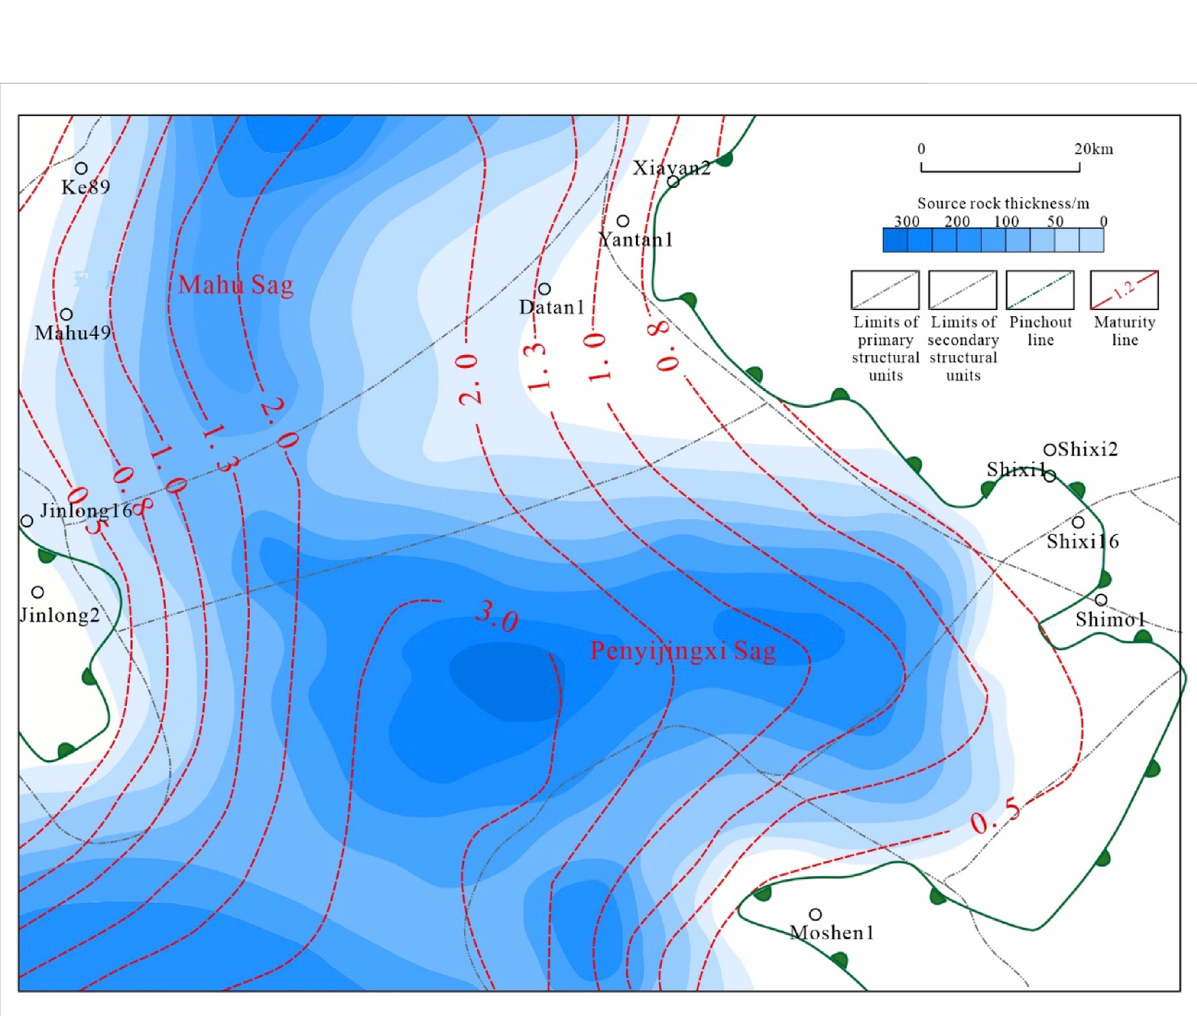
FIGURE 7 Map showing the source rock thickness and maturity in the Fengcheng Formation in the Penyijingxi Sag.